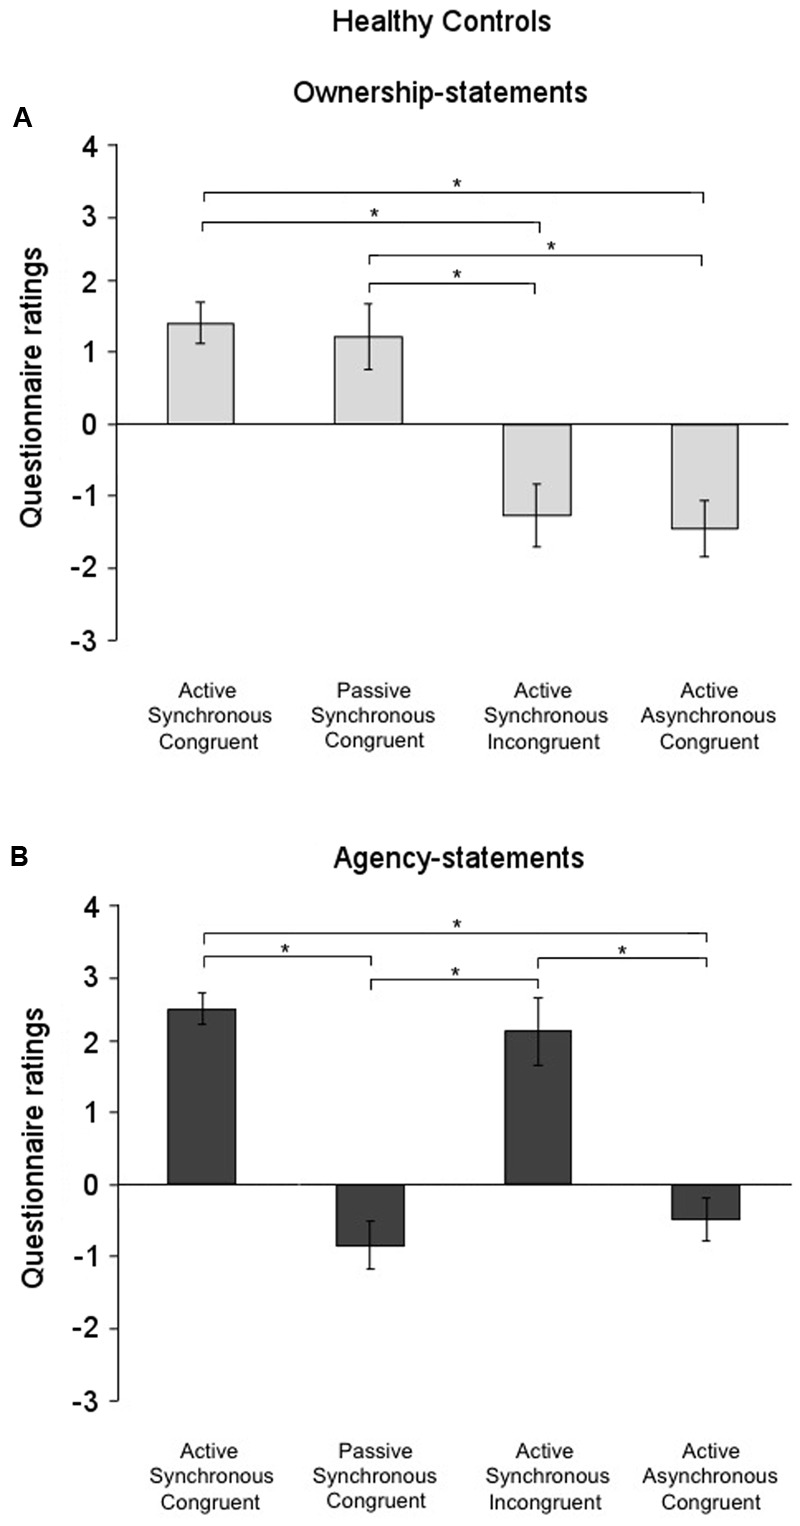
Ownership and agency across conditions in the healthy controls group. (A) Mean scores for the ownership-statements and (B) the agency-statements across conditions in the healthy controls group. Gray lines and asterisks show significant comparisons across conditions. In the functional movement disorders group, agency and ownership were differently elicited by each condition. Error bars indicate standard errors.